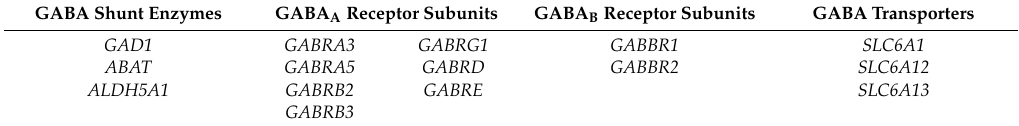
Table 6. GABA system transcripts shared between ACC tumors and the NCI-H295R cell line. GABA Shunt